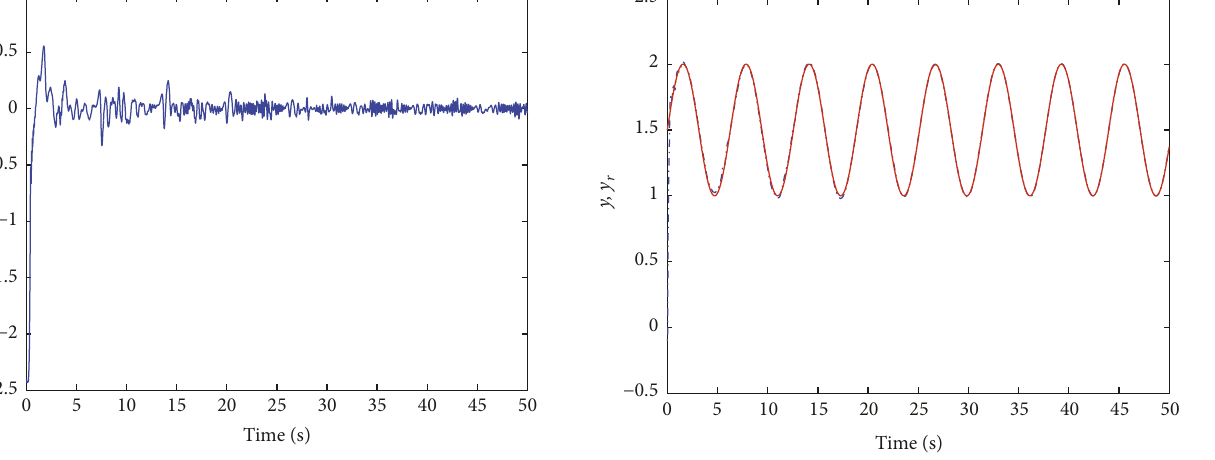
Figure 8: Trajectories of system output signal 𝑦(𝑡) (dash-dotted line) and reference signal 𝑦 𝑟 (𝑡) (solid line).